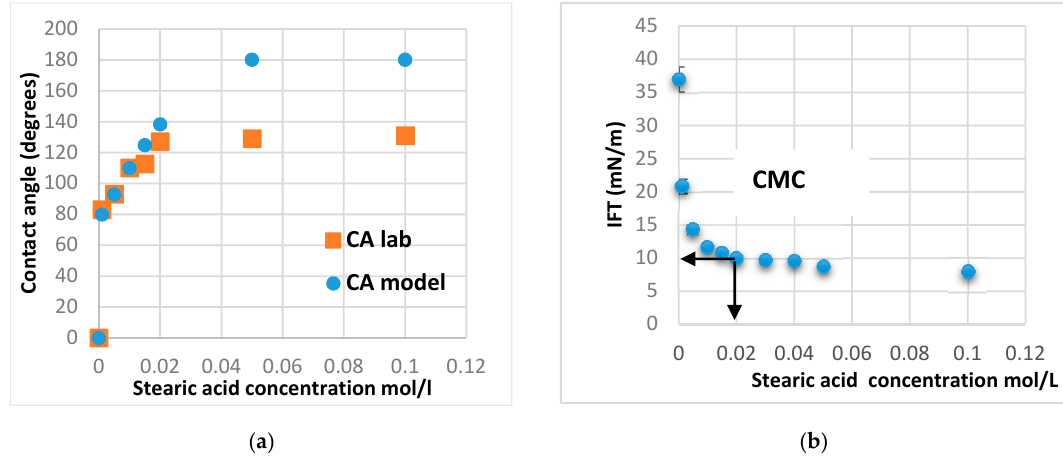
Figure 9. ( a ) Calculated (CA model) and measured (CA lab) contact angle for calcite modified with different stearic acid concentrations. ( b ) IFT between n -decane containing stearic acid and deionised water.